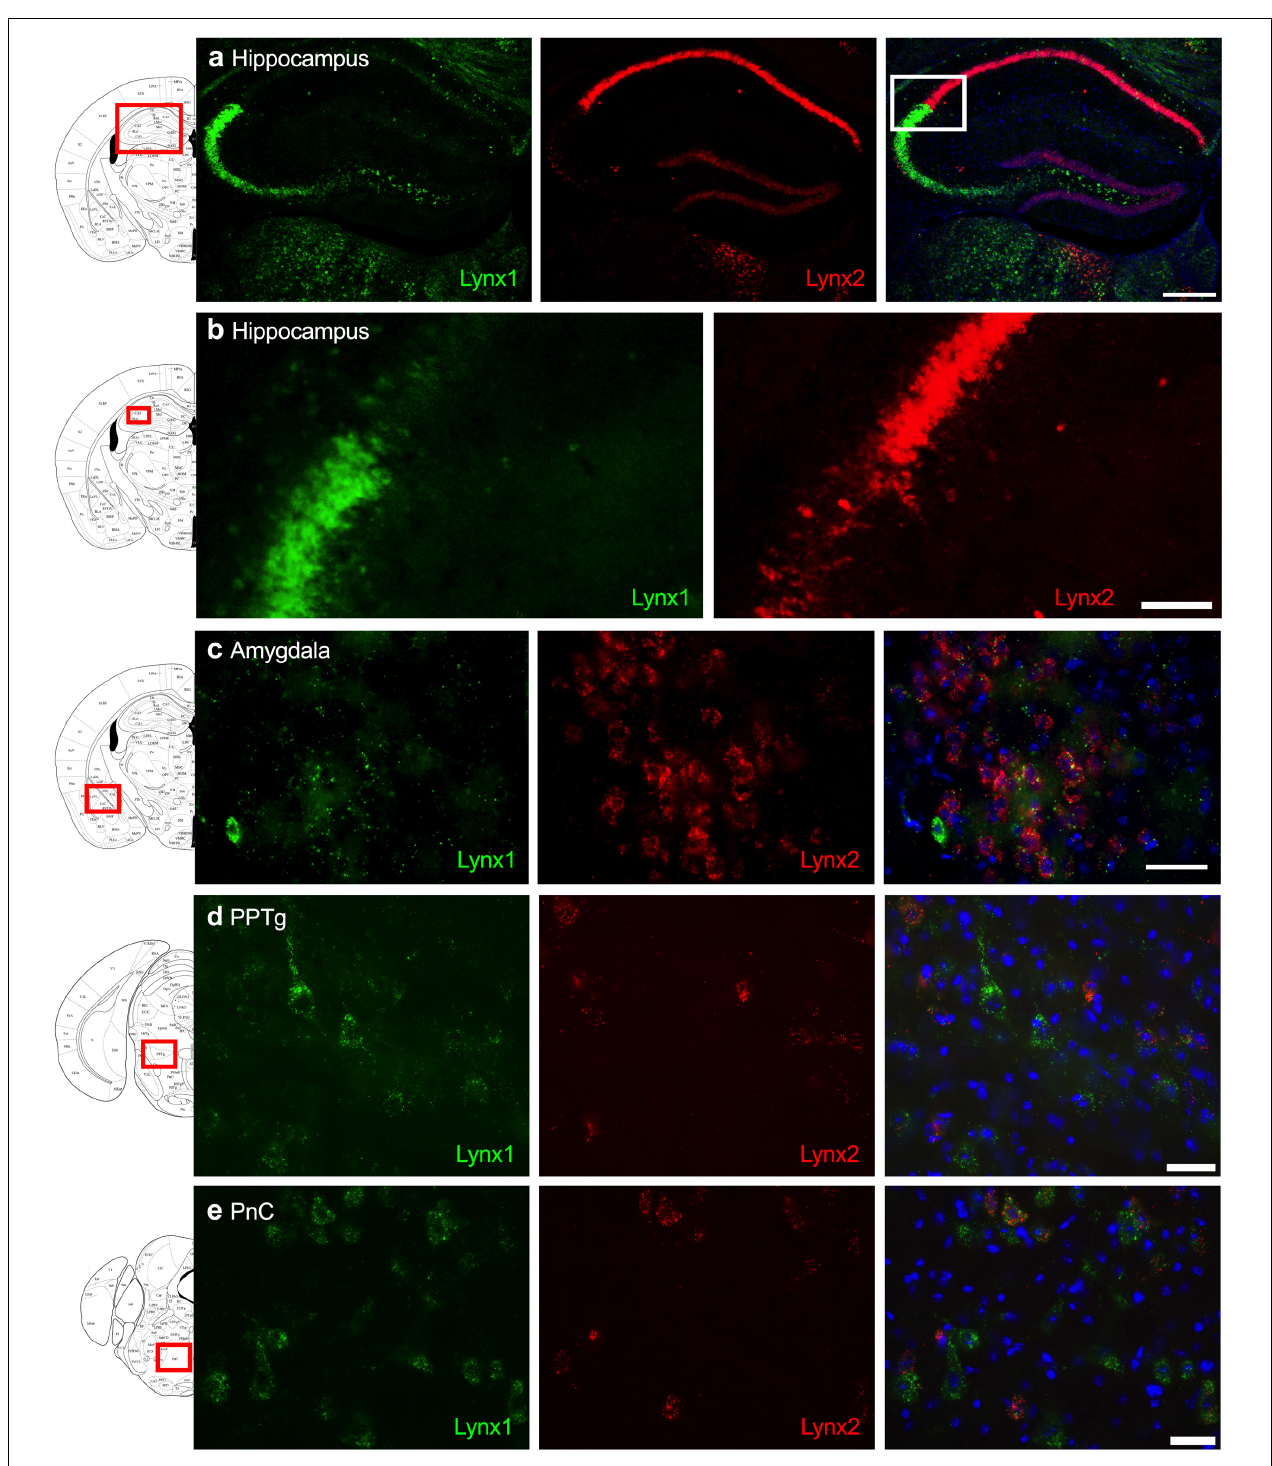
FIGURE 3 | Expression of lynx1 and lynx2 mRNA in the hippocampus, amygdala, pedunculopontine tegmental nucleus (PPTg), pontine reticular nucleus (PnC). (a) Distinct patterns of lynx1 and lynx2 expression were found in the dorsal hippocampus. Interestingly, lynx1 mRNA (green) was densely expressed in the CA2 and CA3 region, whereas lynx2 mRNA (red) was highly expressed in the CA1 region. White box denotes the higher magnification image shown in (b) . (b) Higher magnification of the hippocampus shows distinct differences in the density of lynx1 and lynx2 expression across the CA regions. (c–e) In the central amygdala (c) , PPTg (d) and PnC (e) , cells were found to express lynx1, lynx2, or co-expression both isoforms. The red boxes on the brain plates to the left of each row illustrate the region shown in the respective microscopy images. Blue: DAPI. Scale bar for (a) 100 µ m. Scale bar for (b–e) 40 µ m.